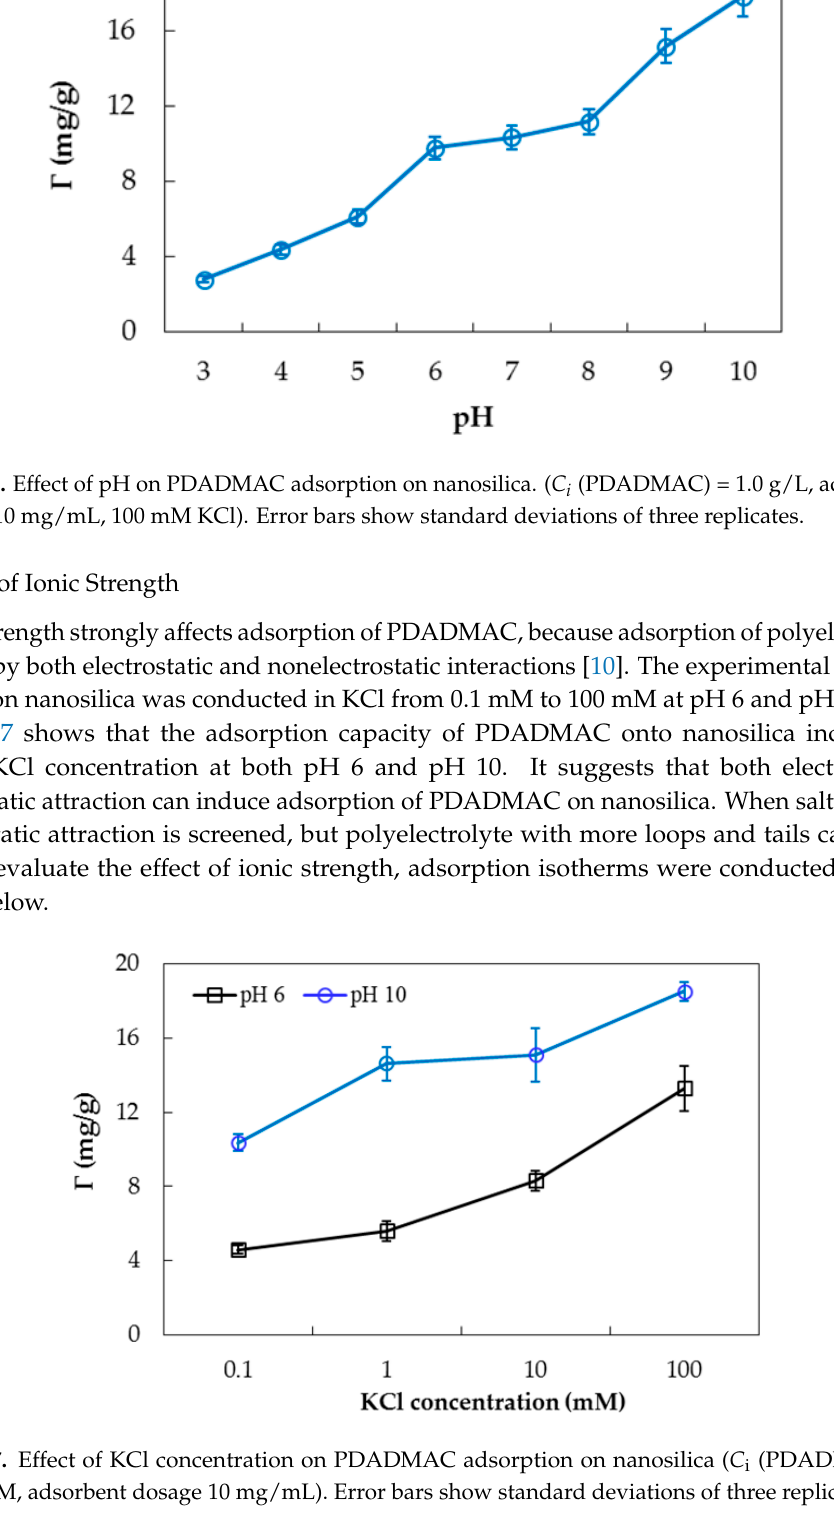
Figure 7. Effect of KCl concentration on PDADMAC adsorption on nanosilica ( C i (PDADMAC) = 1.0 g/L M, adsorbent dosage 10 mg/mL). Error bars show standard deviations of three replicates.